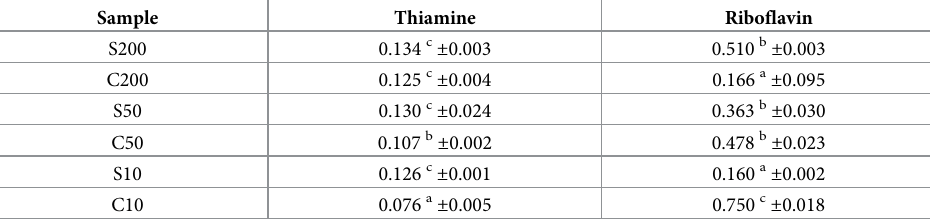
The results are mean values of three determinations ± standard deviation. Values sharing the same letter in a column are not significantly different (P �